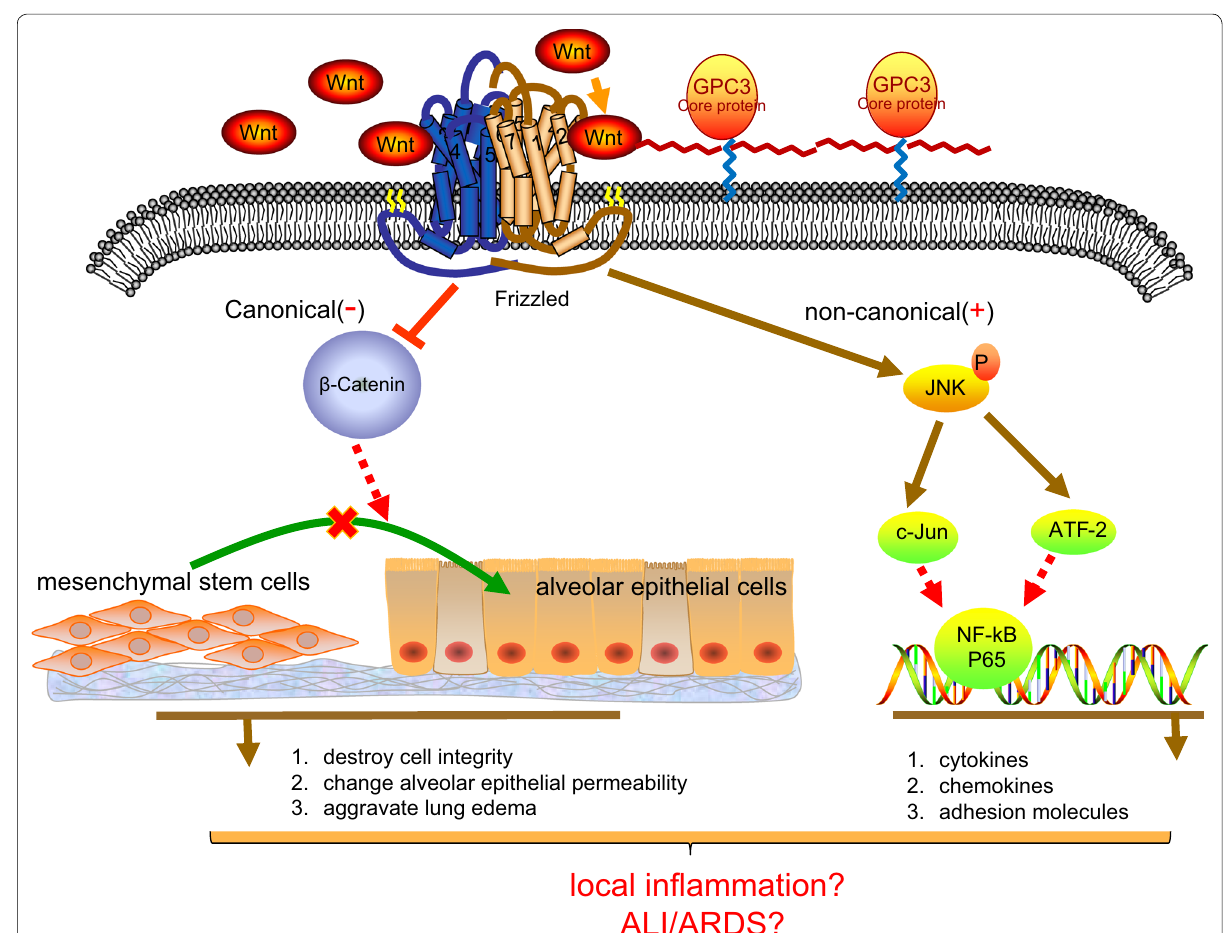
Fig. 2 Potential mechanisms of GPC3 in acute lung injury. Wnt/β-catenin signaling pathway shows its ability to transform the mesenchymal stem cells to alveolar epithelial cells. The suppression of Wnt/β-catenin signaling pathway by GPC3 may destroy cell integrity, change alveolar